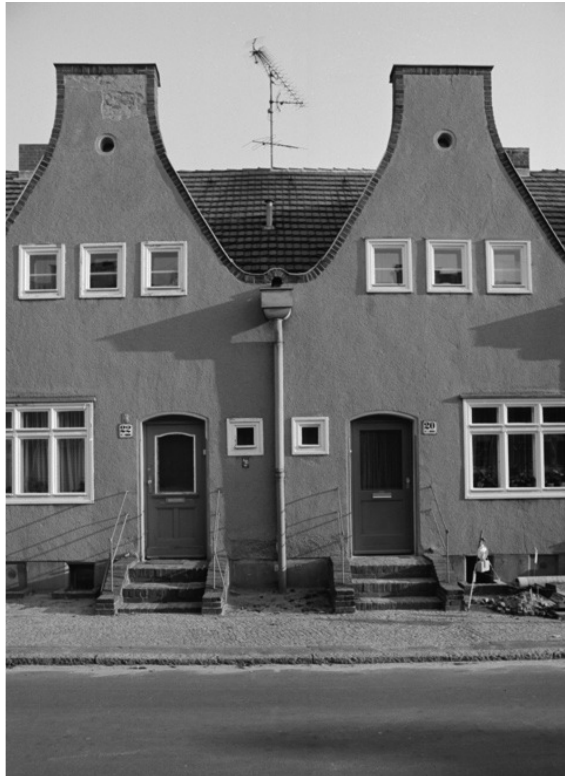
Figure 9. Schmitthenner’s housing on the street “Zwischen den Giebeln” in the Staaken garden city, Spandau, Berlin. Source: Vorsteher (1978), © Bildarchiv Foto Marburg/Dieter